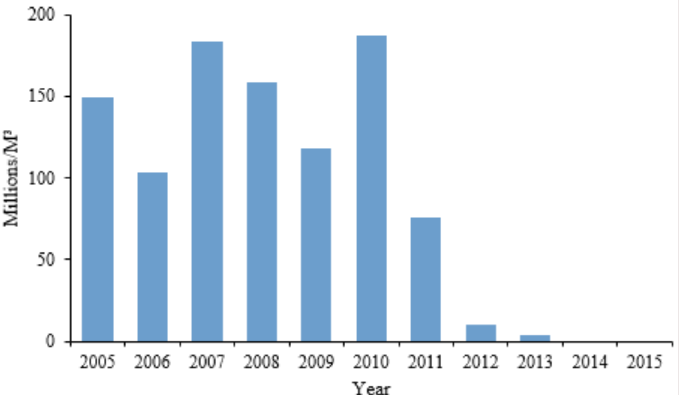
Figure 2. Historical series of inflows for the Epit á cio Pessoa reservoir (2004–2015). Regarding evaporation, there is no measurement of evaporated laminas in the Epit á cio Pessoa reservoir. For this reason, monthly average evaporation data collected from a Class A evaporimetric tank of S ã o Jo ã o do Cariri School of the Federal University of Campina Grande were used. The series is taken as representative because of its proximity to the Epit á cio Pessoa reservoir, and the similarities of its climatic, terrain, and vegetation characteristics. The coefficients (Kp) calculated by Nunes et al. [19], were used to correct the values measured in the Class A tank. In the Epit á cio Pessoa reservoir, other coefficients besides the frequently employed value of 0.7 are used seasonally, since each season of the year has its own climatic conditions and is unique to each location. The monthly averages of evaporated water used in the simulations can be seen in Figure 3.